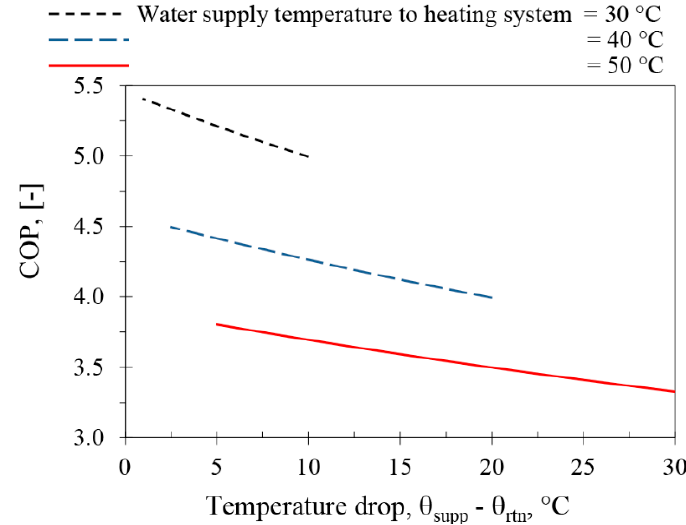
Figure 11. Variation of COP with temperature drop across a heating system in a single-family dwelling. Maximum water flow rate 0.035 kg/s per heating appliance.